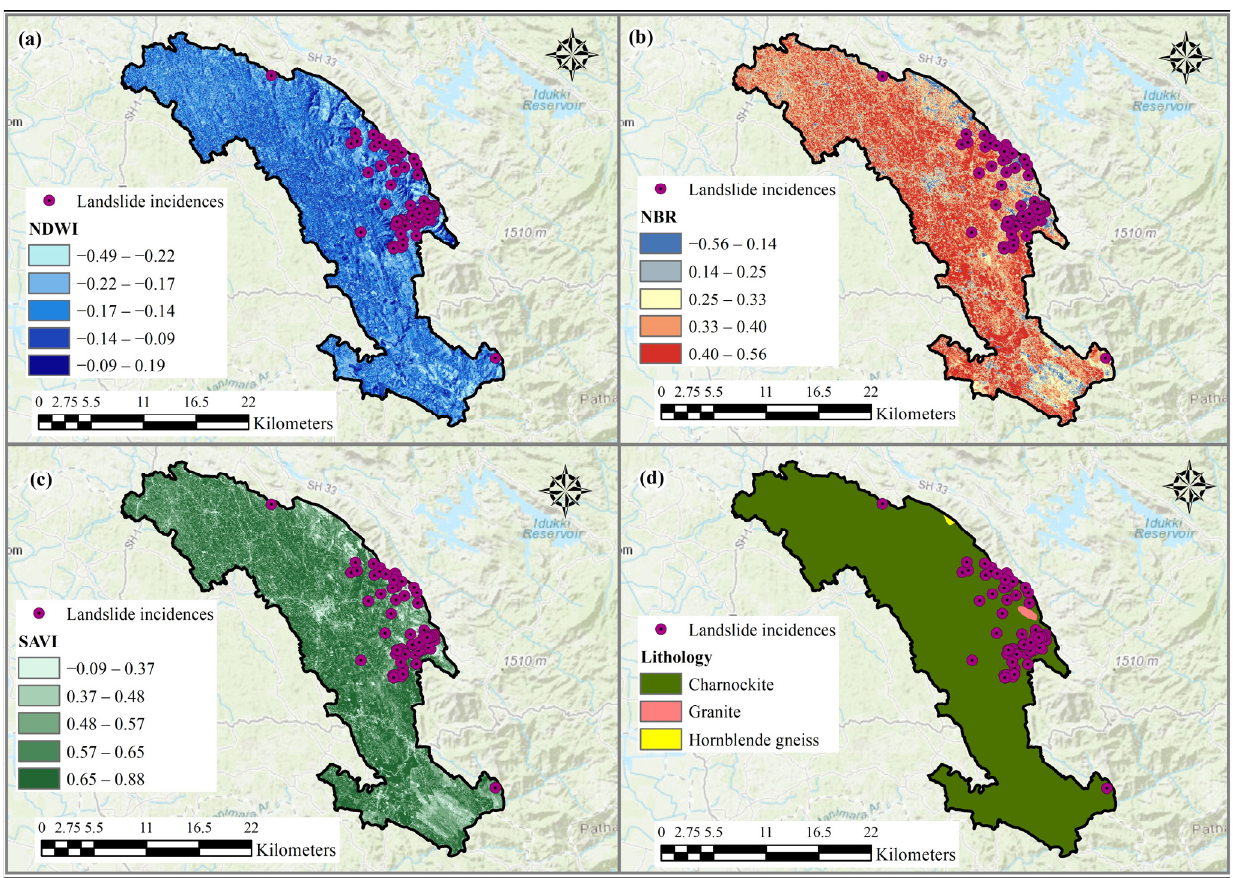
Figure 6. ( a ). NDWI, ( b ). NBR, ( c ). SAVI, ( d ). Lithology.